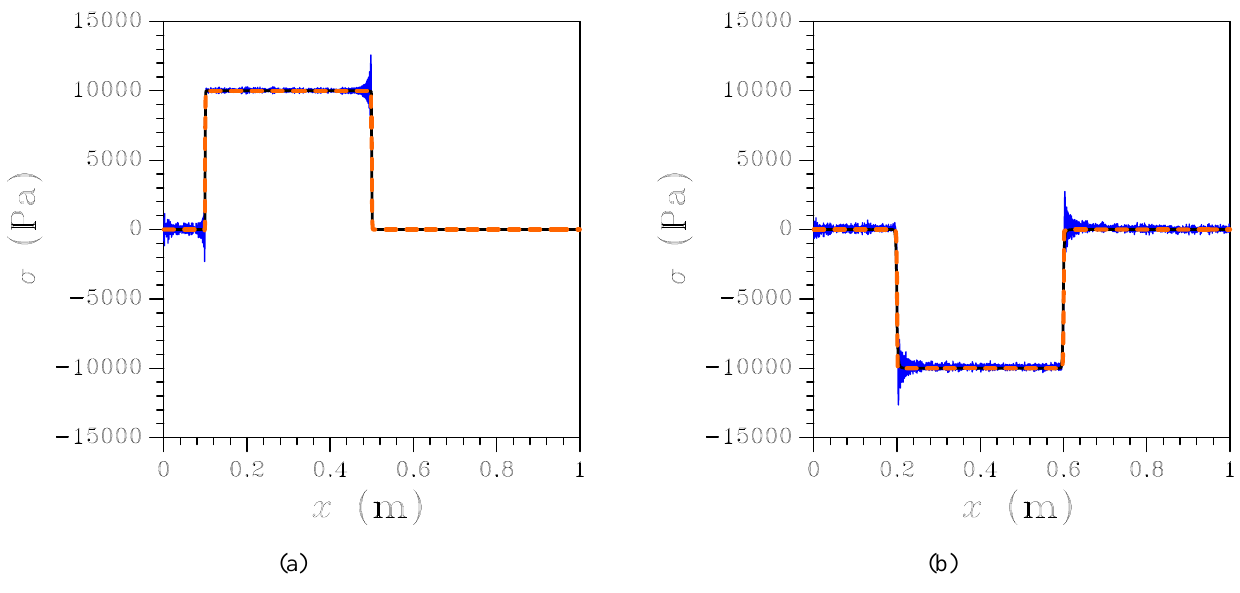
Figure 5. Wave propagating along a homogeneous rod discretized with a structured mesh: stress field at (a) t = 0 . 5 · 10 − 2 s and at (b) t = 1 . 8 · 10 − 2 s. Blue solid line: FE solution; black solid line: standard FE-FCT solution; orange dashed line: newly proposed FE-FCT solution.